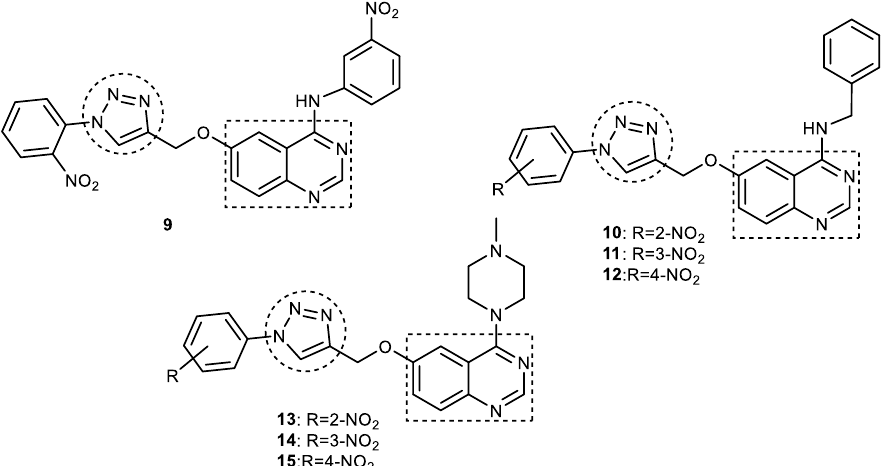
Figure 11. Chemical structures of quinazoline – 1,2,3-triazole hybrids.